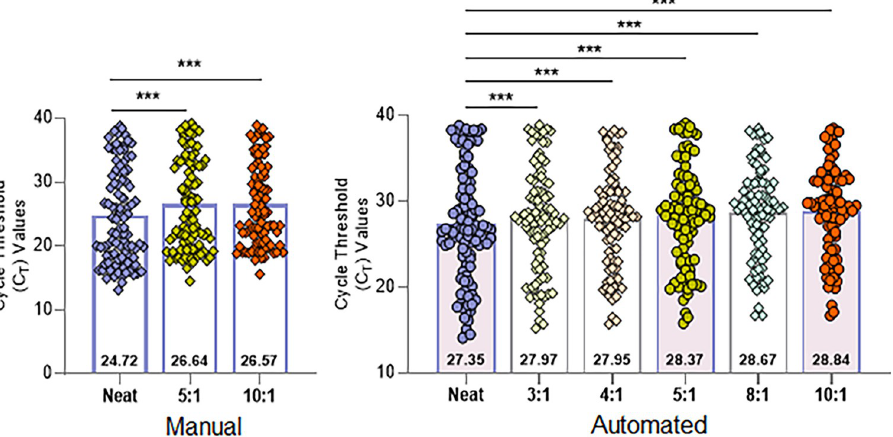
Fig 3. Distribution of Fusion 1 neat and pooled sample test results. Samples used in manual pool generation (left panel) and automated pool generation (right panel). Test results are represented as circles. Numbers within bars represent median values. Two-sided t-test, ��� p <